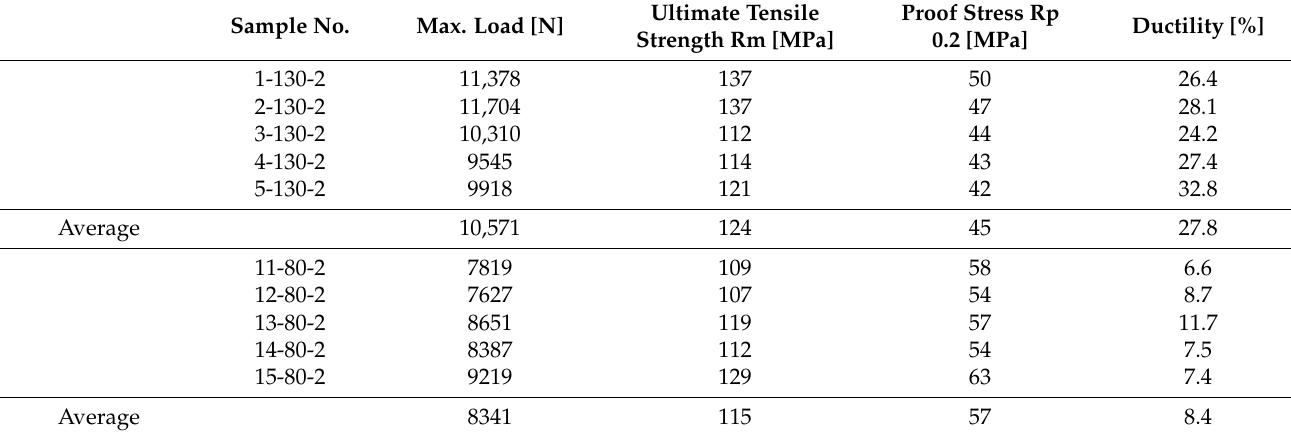
Table 3. Average values of mechanical parameters of samples with integrated RFID tag type no. 2. Sample No.